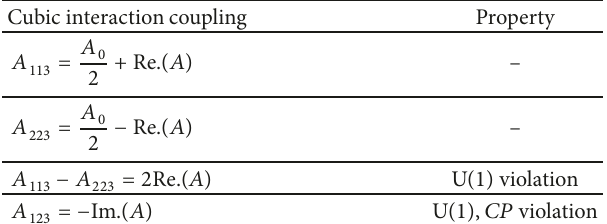
Table 1: The cubic interactions and their properties. Cubic interaction coupling